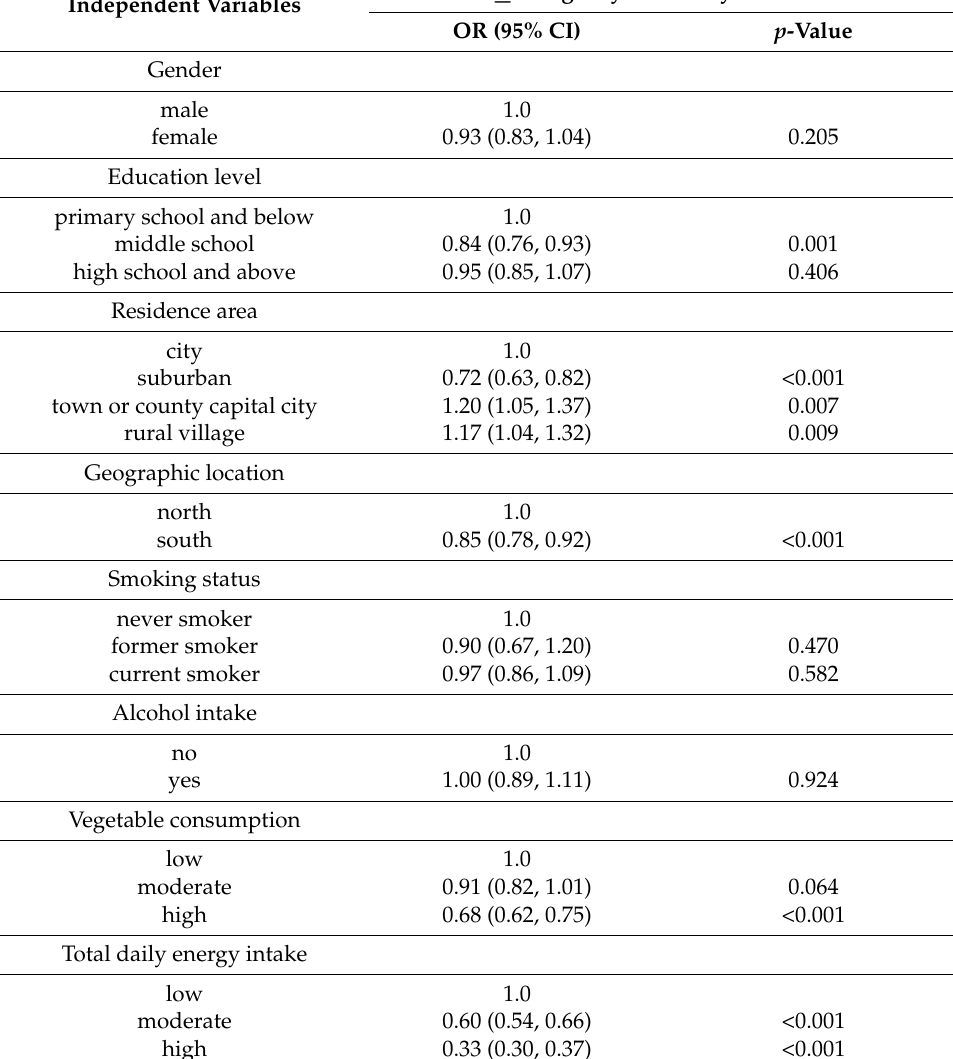
Table 3. Association of the risk of insufficient dietary vitamin C intake (<85 mg/day) with sociodemographic factors using the multiple logistic regression